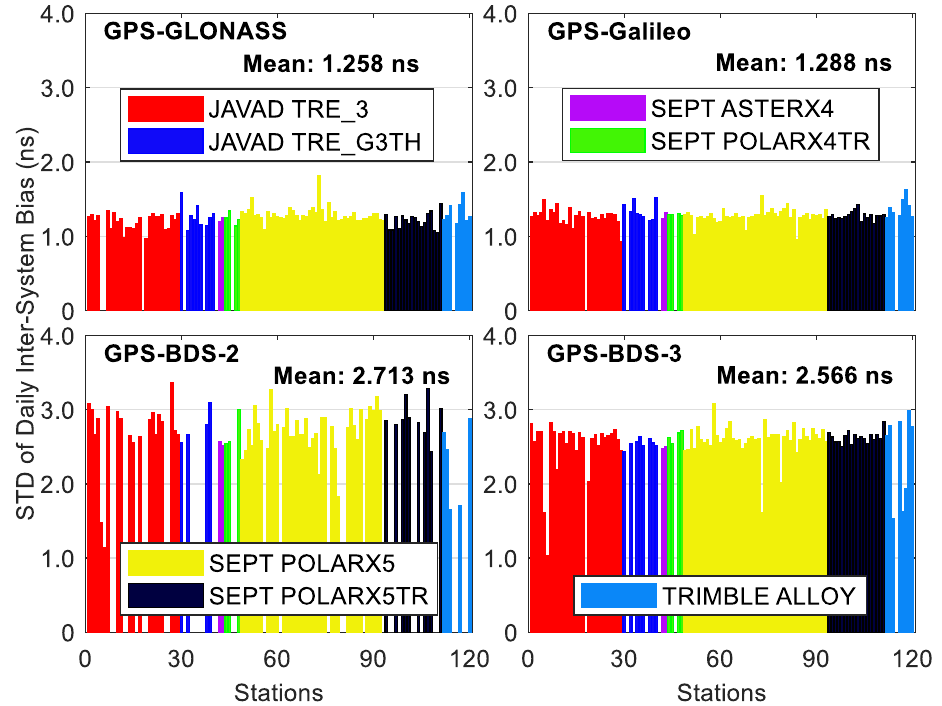
Figure 8. STD statistics of daily ISBs over a month for each station (characterized by the receiver types).